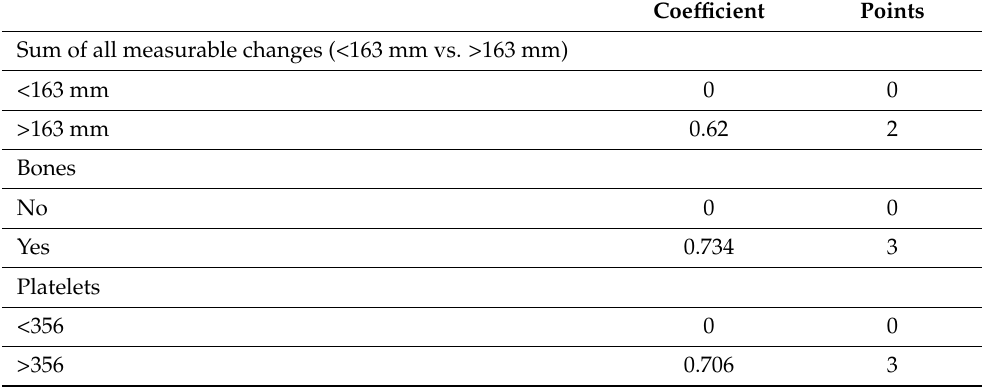
Table 7. Prognostic index.